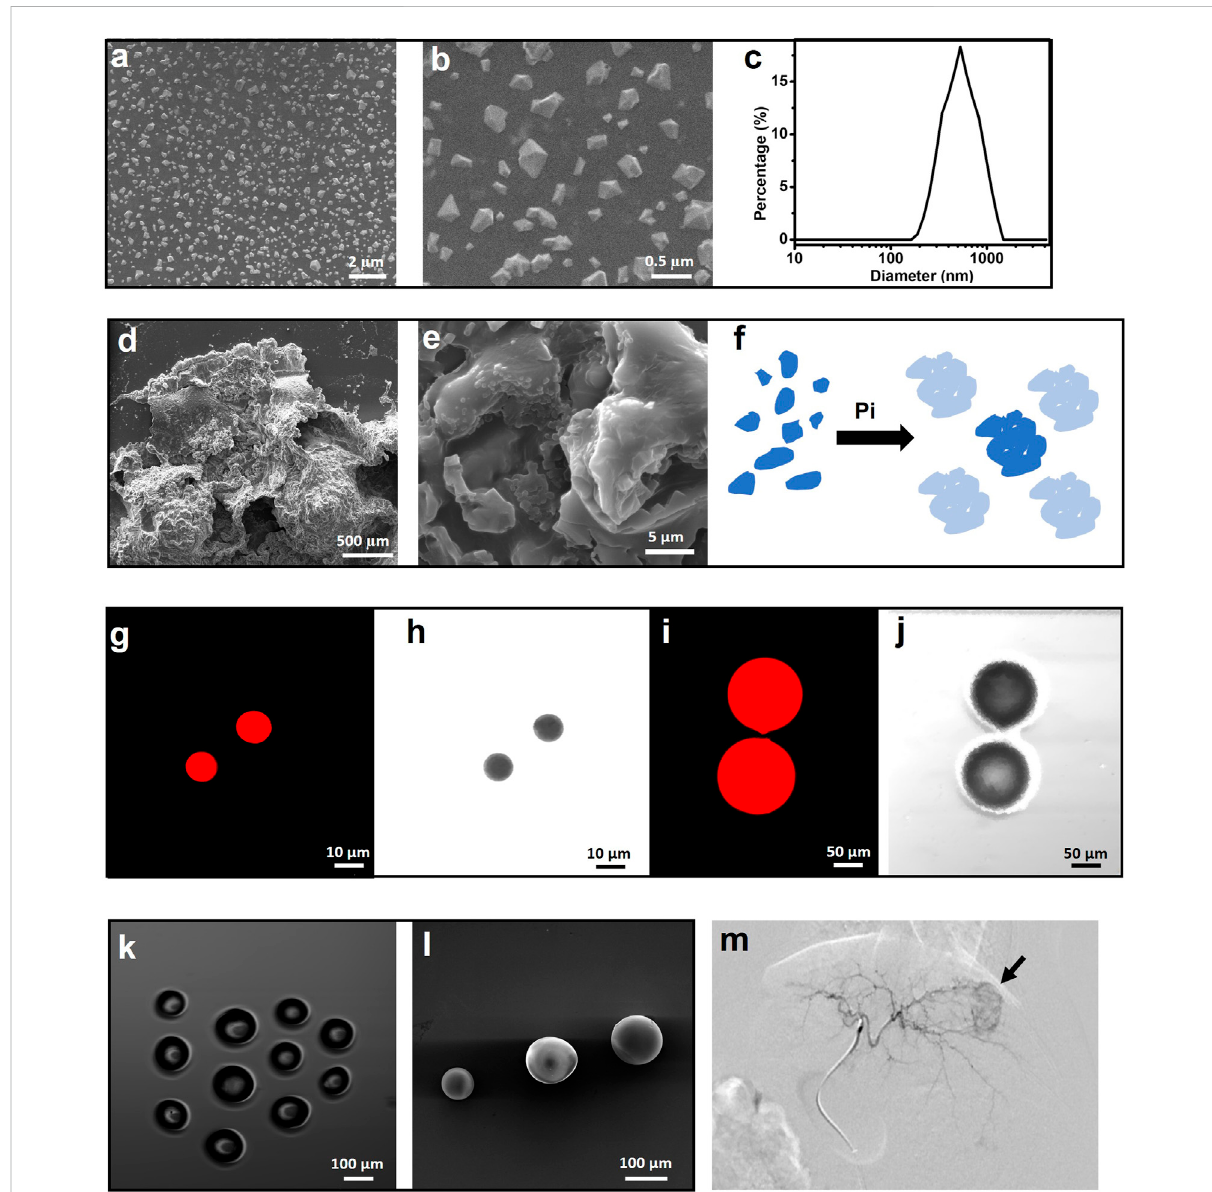
Polyhedral sevelamer particle with a size ranging from 0.2 – 0.5 µm (A – C) and it is Pi-induced swell and aggregation into particles as large as millimeter (D,E) , as simply schemed (F) . Luminescent polystyrene microsphere (LPM) with the size of 10 μ m (G,H) and 100 μ m (I,J) , as recorded by a luminescent microscope. Light microscope (K) and scanning electron microscope (L) images of poly (vinyl alcohol) microsphere with the size of 100 – 300 μ m. (M) Representative VX2 rabbit hepatic angiographic